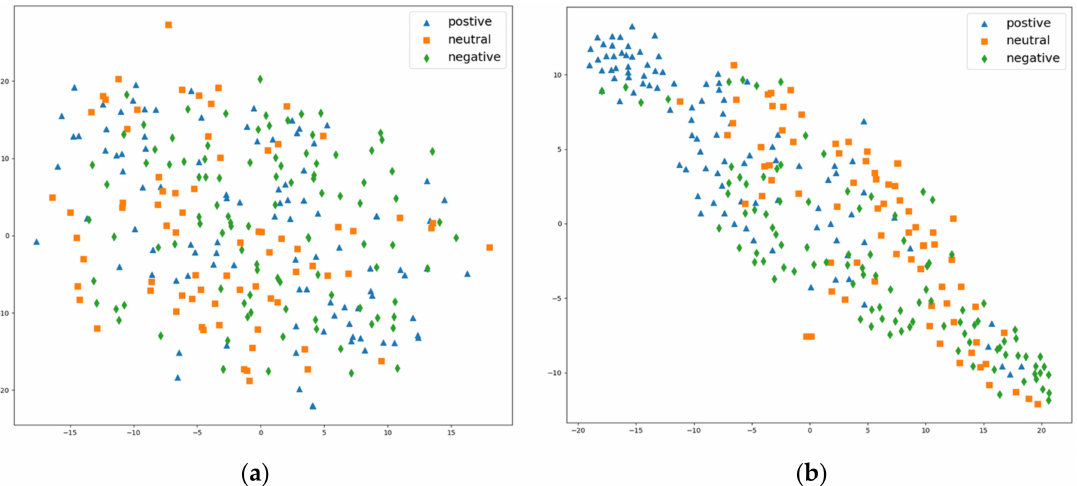
Figure 5. Visualization results of visual features projected to two-dimensional space. ( a ) Visualization of the initial visual features. ( b ) Visualization of the attention-based